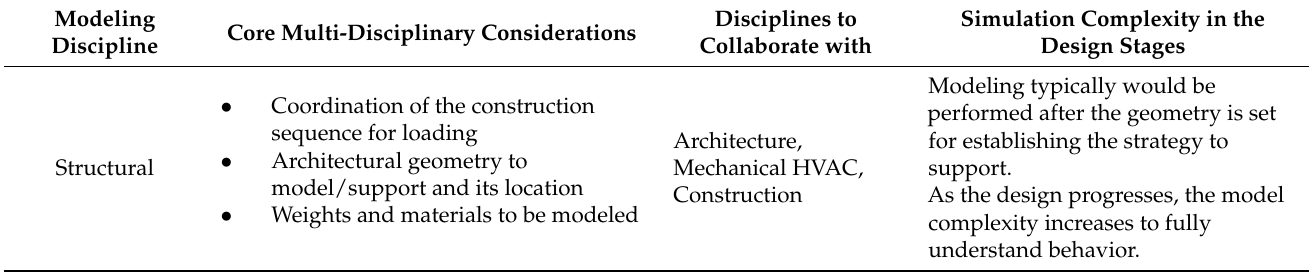
Table 15. Multi-disciplinary Modeling Considerations and